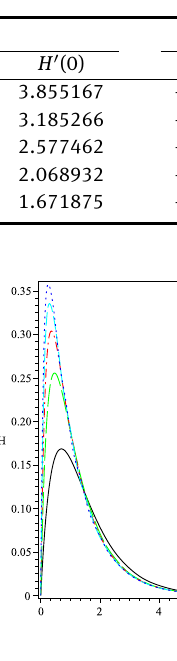
Fig. 6: The profile velocity F (cid:48) ( η ) obtained by the direct RBFs for different values of ϕ at β = 6 and ε = 0.1 .